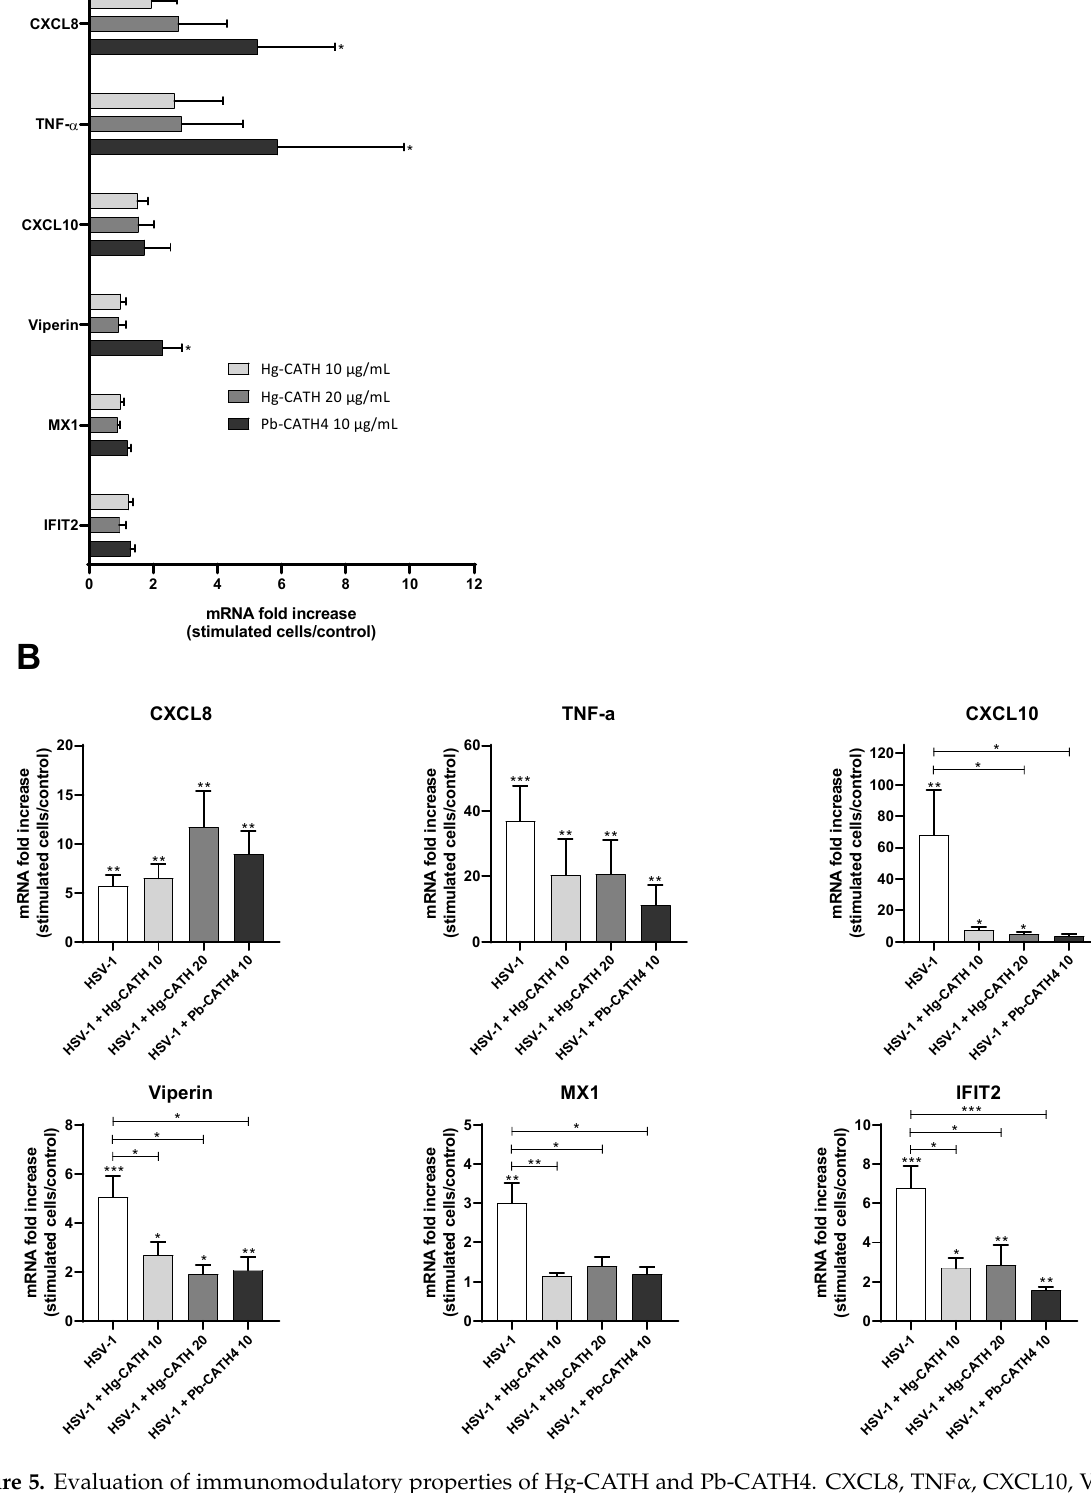
Figure 5. Evaluation of immunomodulatory properties of Hg-CATH and Pb-CATH4. CXCL8, TNF α , CXCL10, Viperin, MX1, and IFIT2 mRNA expression has been measured in keratinocytes stimulated by Hg-CATH (10 or 20 µg/mL) or Pb-CATH4 (10 µg/mL) ( A ). This expression has been then measured in keratinocytes stimulated with peptides at the same concentrations, and infected with HSV-1 at an MOI of 0.1 or mock-infected for 24 h ( B ). Data are represented as mean + SEM five independent experiments. * p < 0.05, ** p < 0.01, *** p < 0.001.